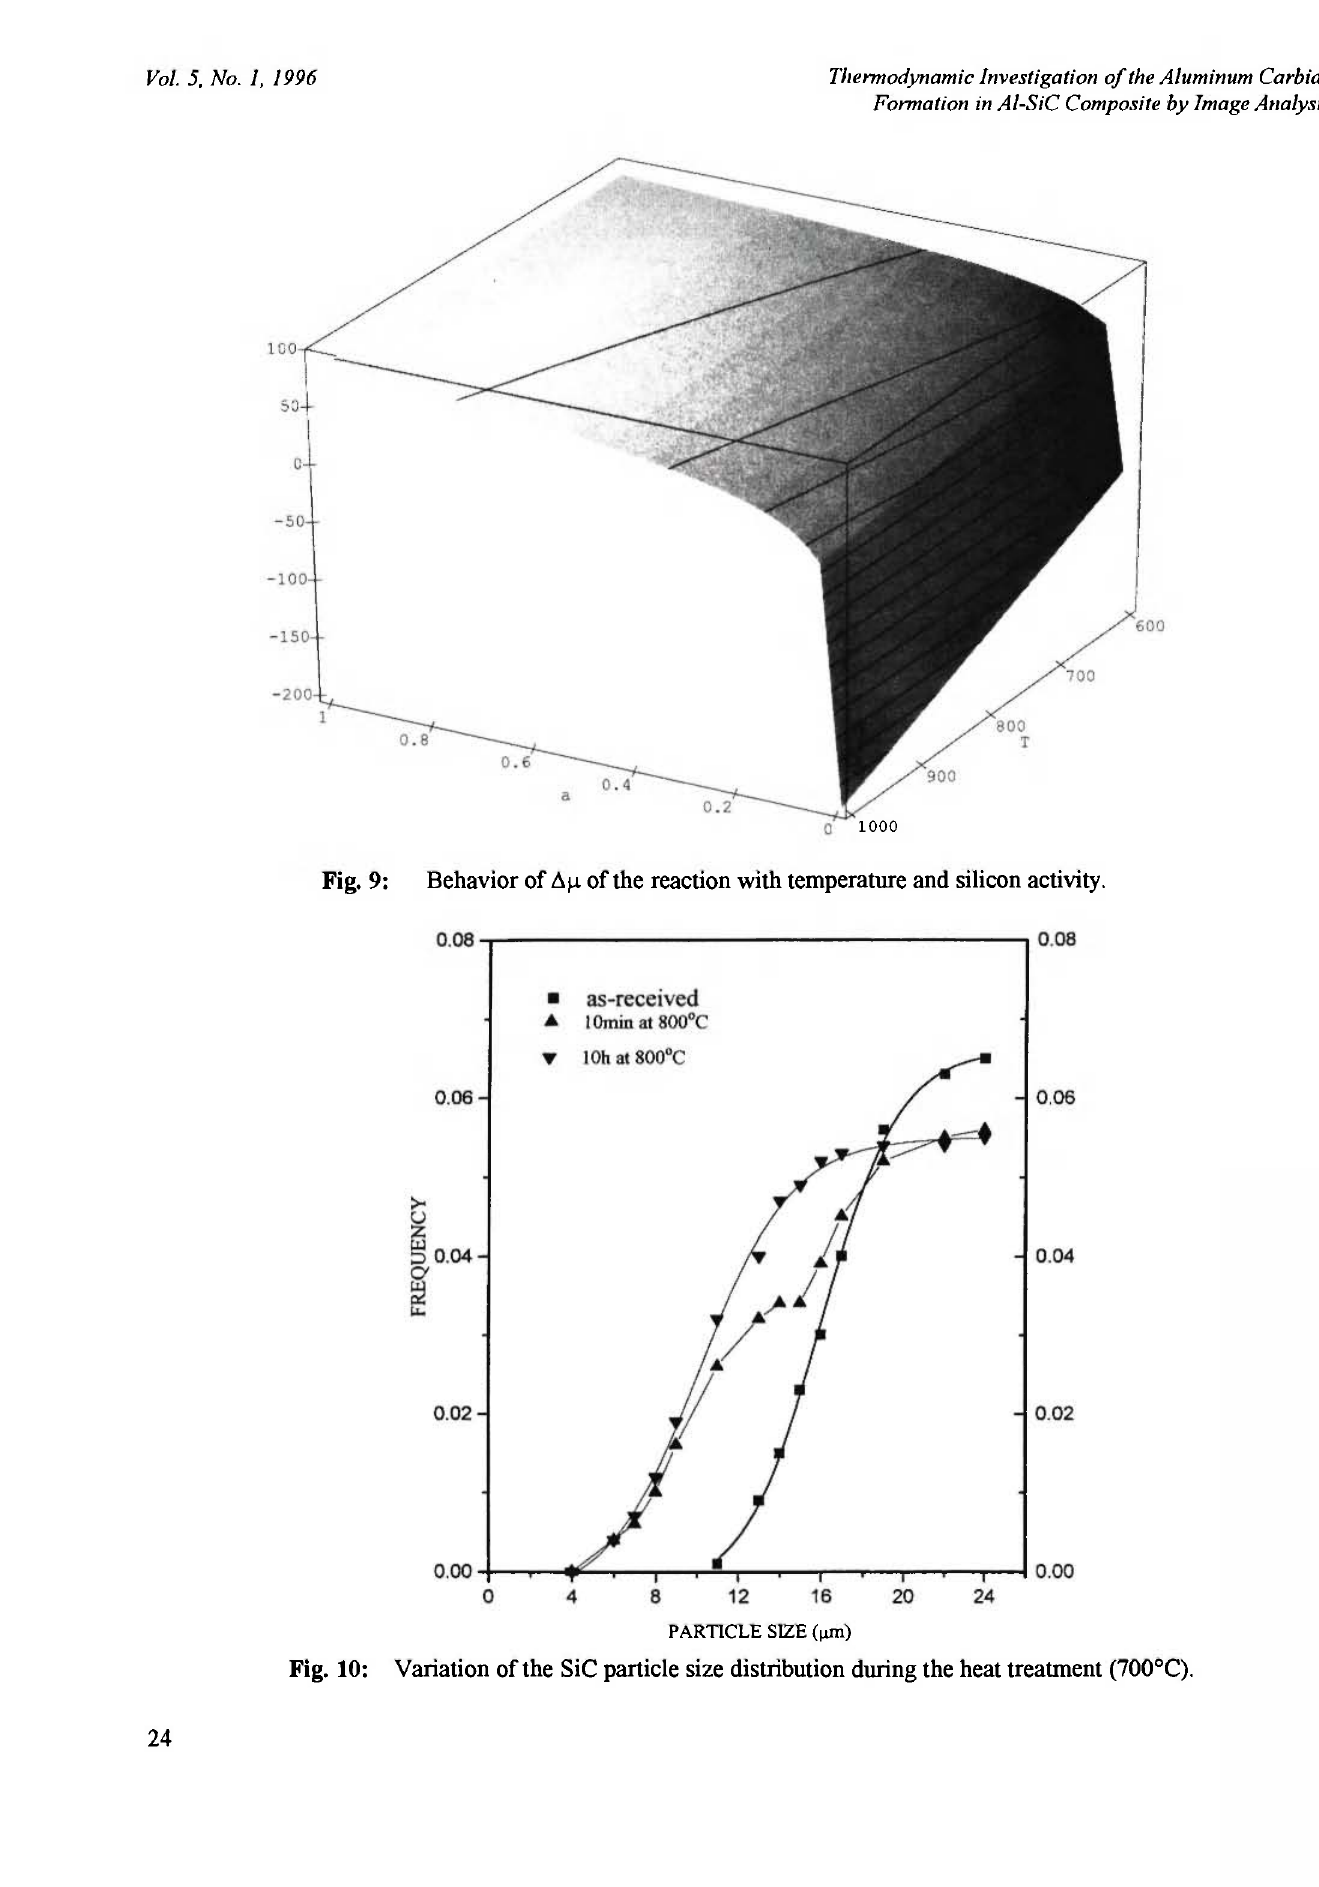
Fig. 10: Variation of the SiC particle size distribution during the heat treatment